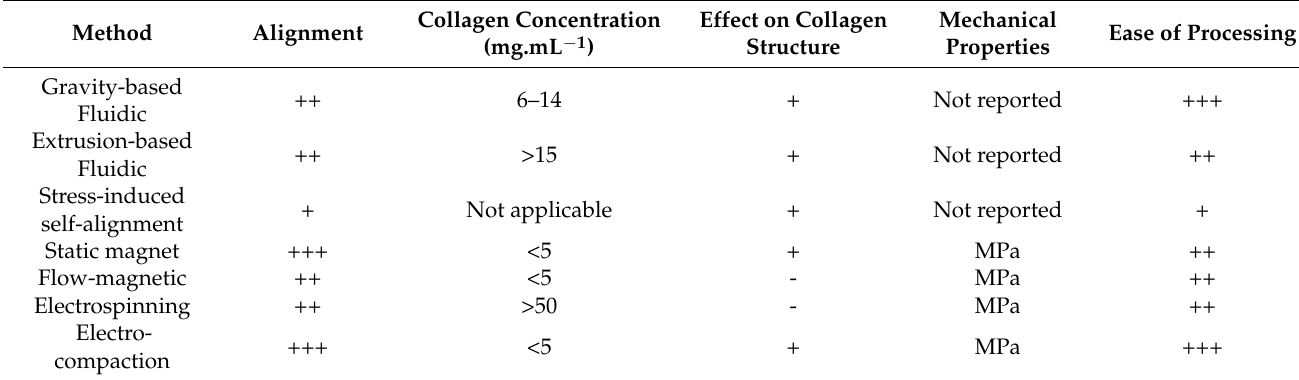
Table 2. Summary of collagen alignment